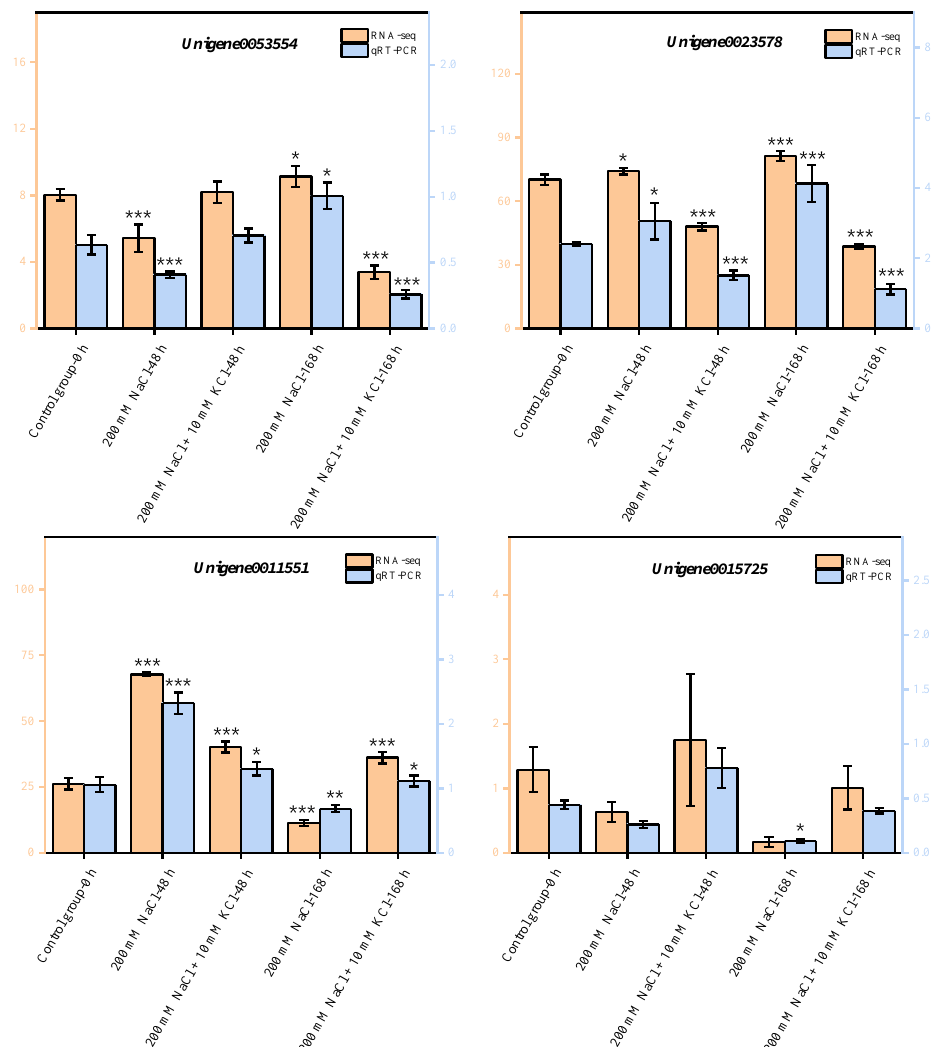
Figure 4. Validation of DEGs by qRT ‐ PCR: Eight DEGs were randomly selected for qRT ‐ PCR vali ‐ dation. The error bars were obtained from multiple replicates of qRT ‐ PCR. Note: p ≥ 0.05 is not Figure 4. Validation of DEGs by qRT-PCR: Eight DEGs were randomly selected for qRT-PCR vali- Figure 4. Validation of DEGs by qRT-PCR: Eight DEGs were randomly selected for qRT-PCR valida- Figure 4. Validation of DEGs by qRT-PCR: Eight DEGs were randomly selected for qRT-PCR vali- marked; * 0.01 < p < 0.05; ** 0.001 < p < 0.01; *** p ≤ 0.001. : Numerical value is shown dation. The error bars were obtained from multiple replicates of qRT-PCR. Note: p ≥ 0.05 is not tion. The error bars were obtained from multiple replicates of qRT-PCR. Note: p ≥ 0.05 is not marked; dation. The error bars were obtained from multiple replicates of qRT-PCR. Note: p ≥ 0.05 is not on the right side of the Y axis; marked; * 0.01 < p < 0.05; ** 0.001 < p < 0.01; *** p ≤ 0.001 . : Numerical value is shown marked; * 0.01 < p < 0.05; ** 0.001 < p < 0.01; *** p ≤ 0.001 . : Numerical value is shown * 0.01 < p < 0.05; ** 0.001 < p < 0.01; *** p ≤ 0.001. : Numerical value is shown on the right on the right side of the Y axis; : Numerical value is shown on the left side of the Y axis. on the right side of the Y axis; : Numerical value is shown on the left side of the Y axis. side of the Y axis; : Numerical value is shown on the left side of the Y : Numerical value is shown on the left side of the Y axis.